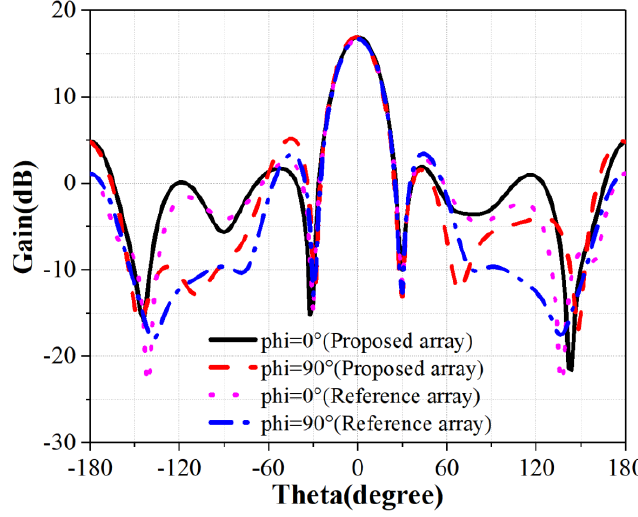
Figure 20. Radiation far−field patterns of the reference and proposed array antenna.